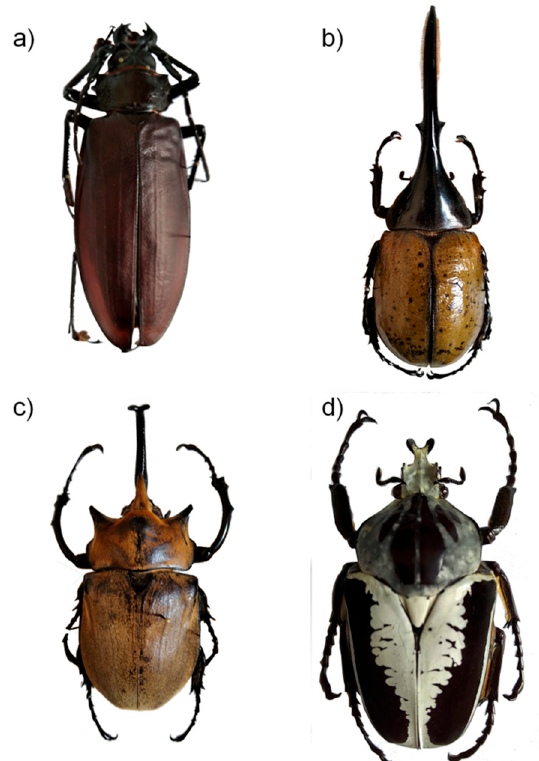
Figure 1. The largest beetle species in the world are living in tropical forests. In this plate: Titanus giganteus from French Guyana ( a ), Dynastes hercules from Colombia ( b ), Megasoma elephas from Mexico ( c ), and Goliathus regius from Ghana ( d ). All specimens are currently stored in the “Luiselli Entomological collection”, Rome, Italy. Photos: L. Luiselli.